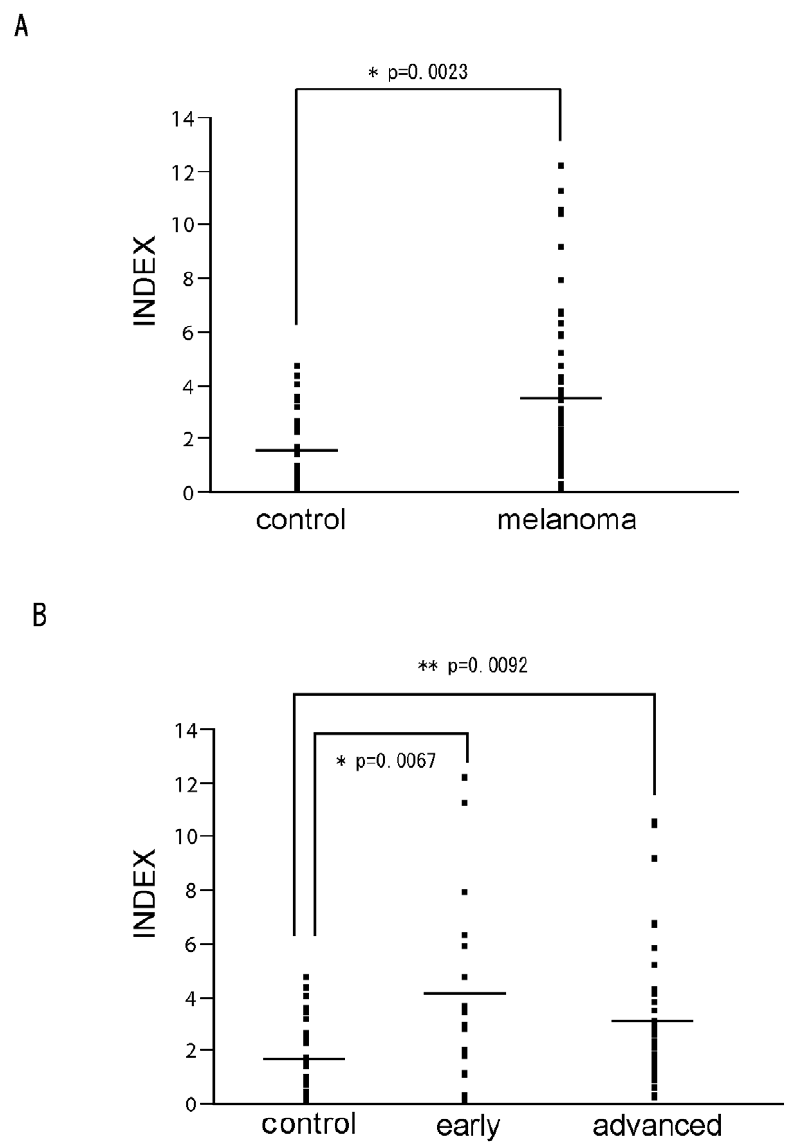
Figure 4. Quantification of anti-BPAG1 auto-antibodies in melanoma patients. (A) The levels of anti-BPAG1 auto-antibodies in sera collected from healthy volunteers and melanoma patients were quantified using a MESACUP BP230 ELISA Kit. The INDEX values were plotted and the average INDEX values as shown ( 6 S.E.M.) for control subjects (1.64 6 0.27) and melanoma patients (3.47 6 0.40). (B) The melanoma patients were classified using the American Joint Committee on Cancer (AJCC) 2002 staging criteria. In situ , stage I or stage II patients were categorized as ‘‘early’’, while stage III or stage IV patients were categorized as ‘‘advanced’’. The average INDEX values ( 6 S.E.M.) of early and advanced melanoma patients were 4.14 6 0.83 and 3.15 6 0.43, respectively; the bars indicate the average INDEX value. doi:10.1371/journal.pone.0010566.g004 were detected in mice showing tumor regression [38]. The efficiency of Treg-cell depletion may correlate with the emergence of auto-antibodies. Thus, the presence of anti-BPAG1 auto- antibodies may correlate with the occurrence of autoimmune responses in melanoma patients. By quantification of anti-BPAG1 auto-antibodies, it maybe possible to predict the immune status of cancer patients. In theory, immunotherapy against melanoma,